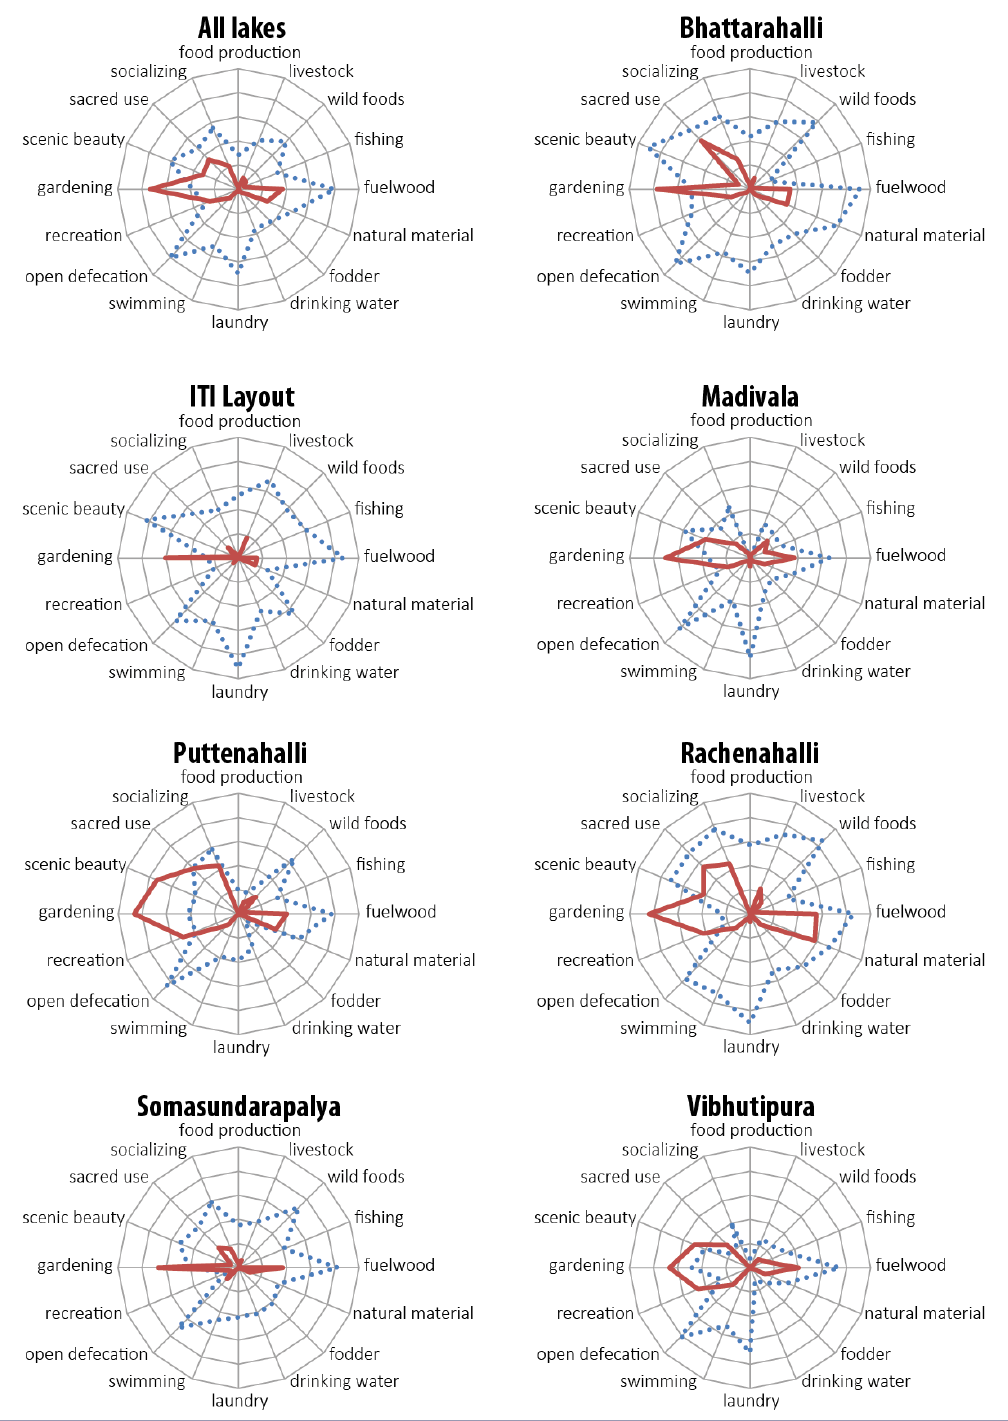
Fig. 5 . Changes in the use of ecosystem services for all lakes together (top left panel) and for each individual lake for both past conditions (around 1980, dashed line) and current conditions (2015, solid line). Axis indicates the share of households using the services from 0% (center) to 100% (outer